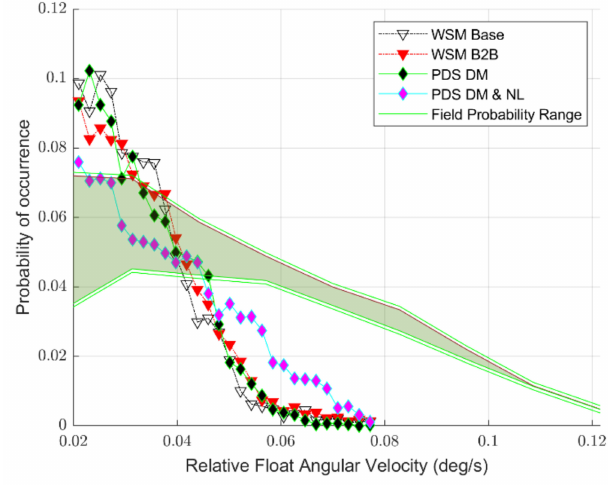
Figure 8. WEBS wave reconstruction regular float angular velocity probability.